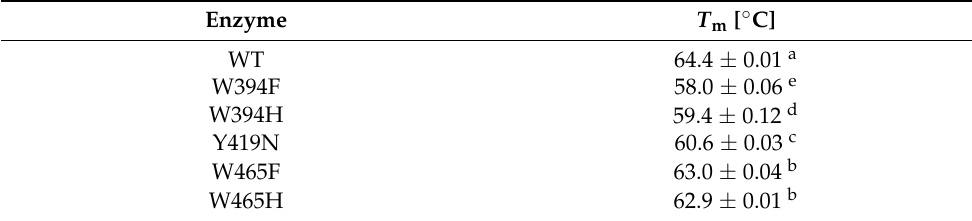
Table 4. Thermal stability of LnbB WT and selected variants determined as the thermal unfolding transition midpoint, T m in ◦ C, at which half of the protein population is unfolded—often referred to as the melting temperature. Superscript letters ( a–e ) indicate significant difference in the T m value between enzyme variants ( p < 0.05).